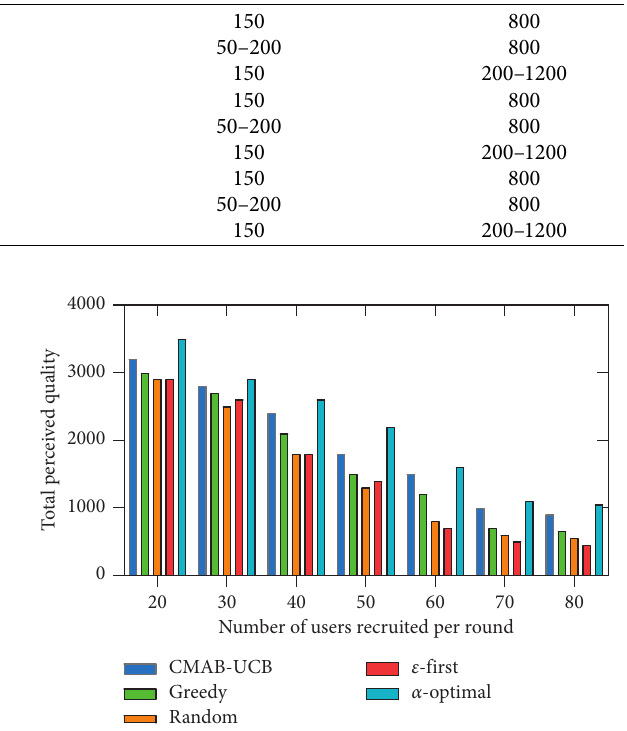
Figure 2: The relationship between perceived quality and user recruitment in each round ( b � 5000).